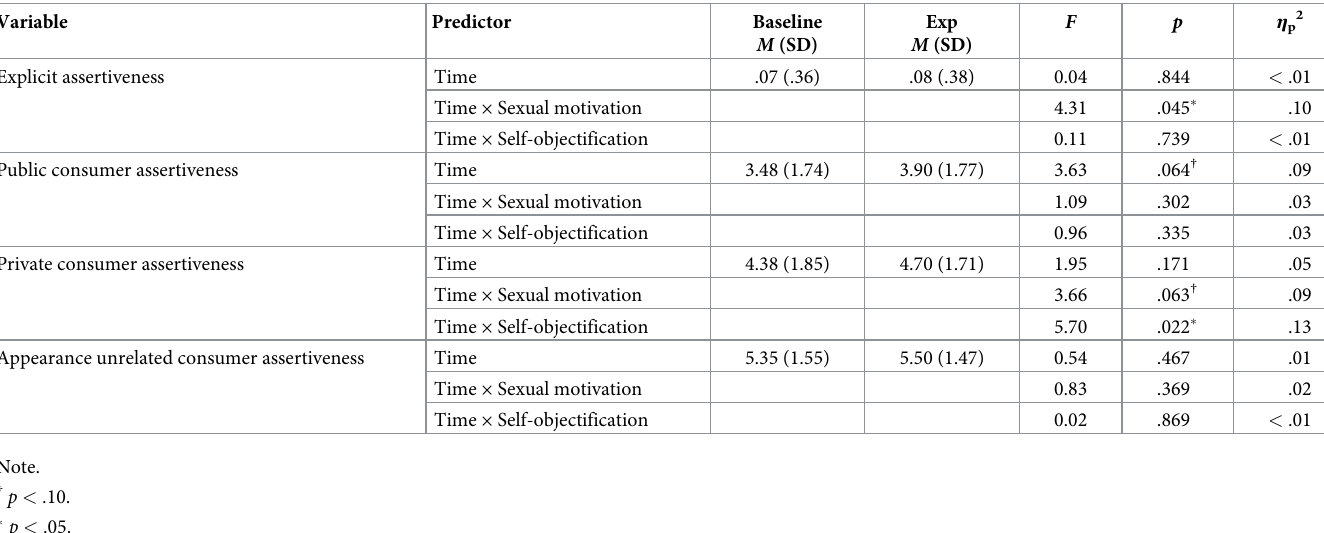
Table 2. The effect of beautification (time), sexual motivation, and self-objectification on explicit assertiveness and assertive behavioral intentions in three domains in Experiment 2.